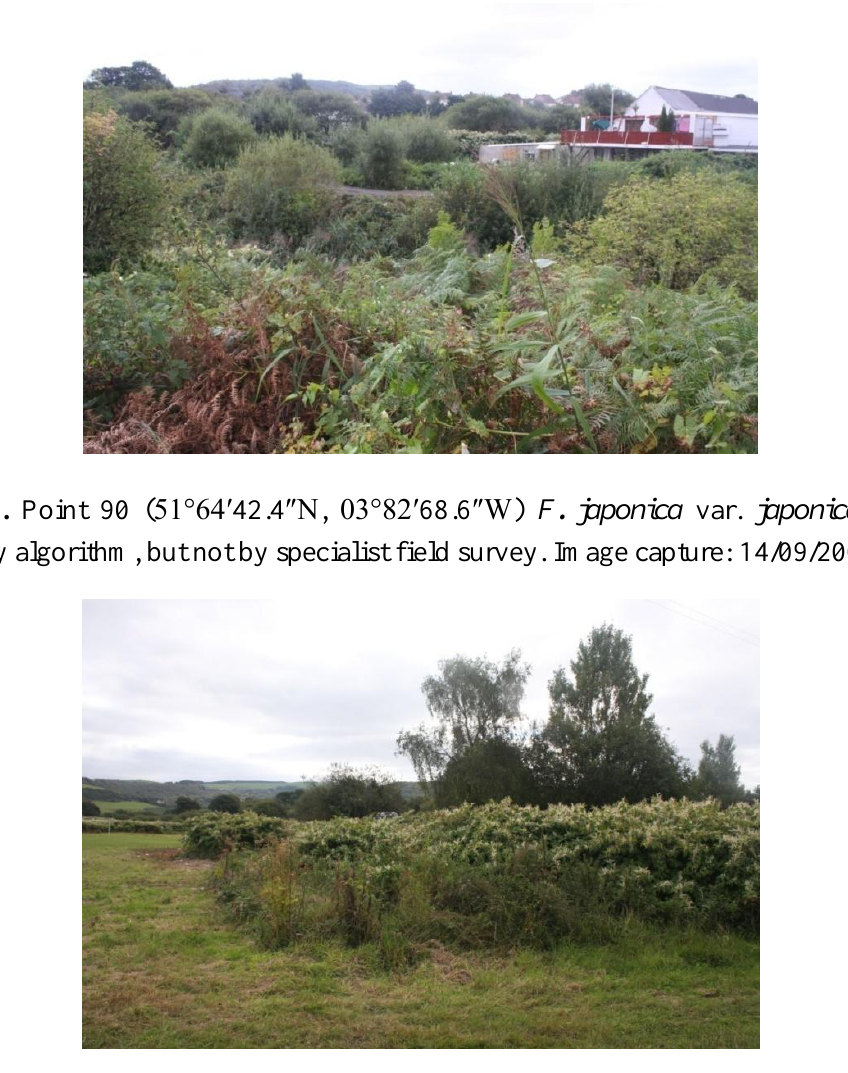
Figure 12. Point 30 (51°64′62.0″N, 03°82′39.9″W) F. japonica var. japonica stand(s) detected by algorithm, but not by specialist field survey. Image capture: 14/09/2009.